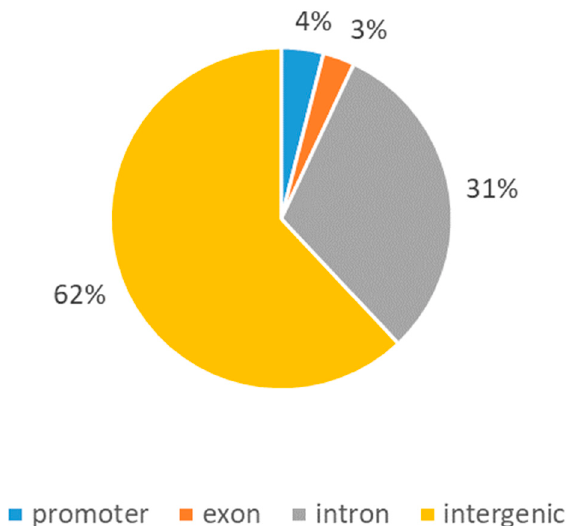
Figure 2. Differential methylation annotations of CpG.